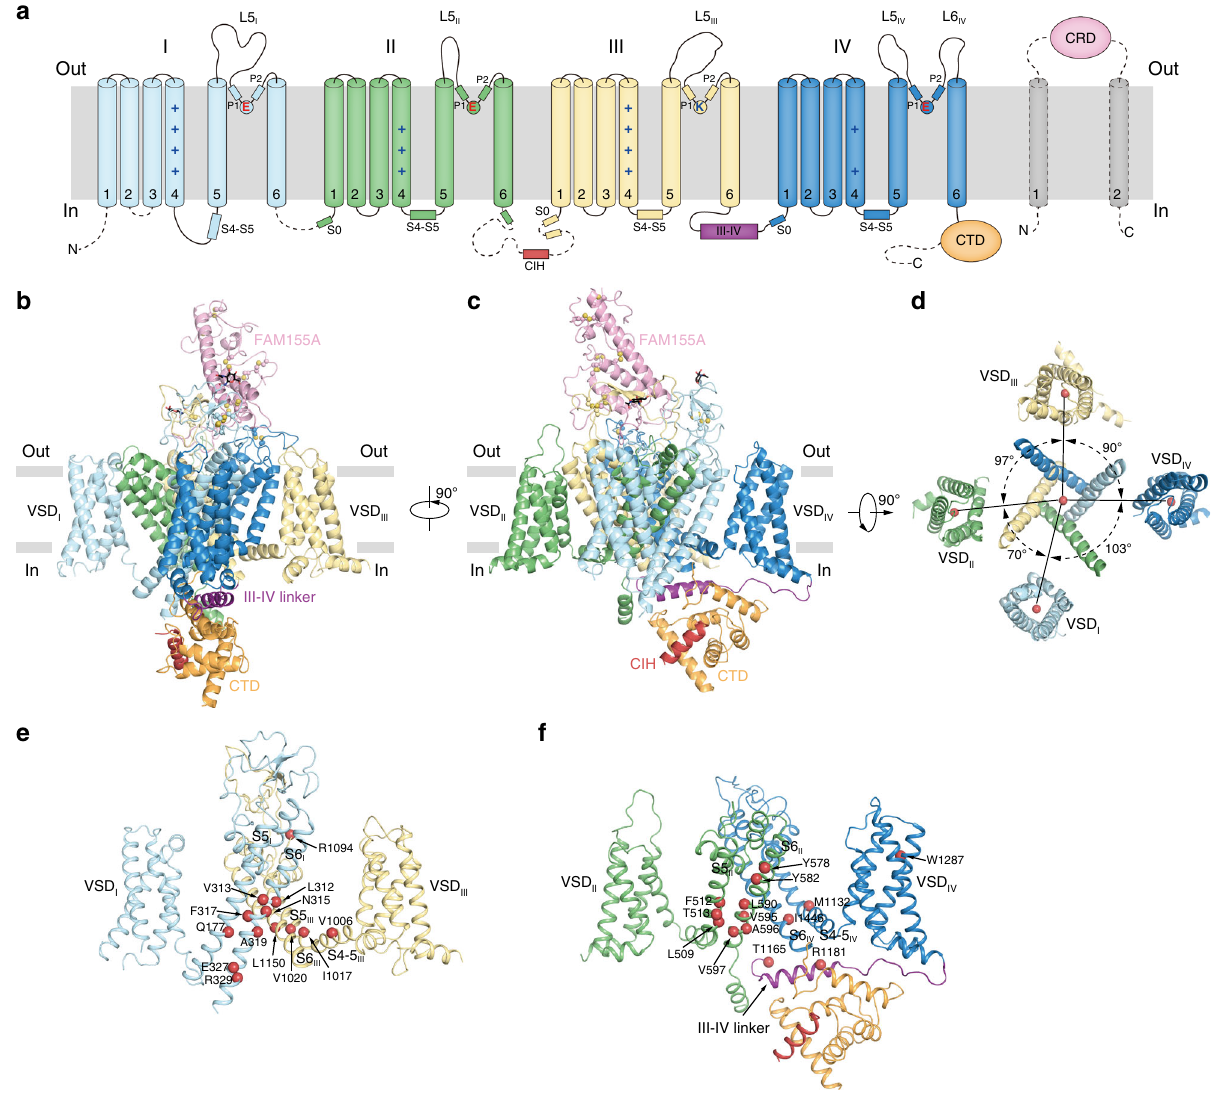
Fig. 1 Overall structure of NALCN and FAM155A complex. a Topology of NALCN and FAM155A subunits. Helices are shown as cylinders, unmodeled disordered regions are shown as dashed lines. The phospholipid bilayer is shown as gray layers. CTD C-terminal intracellular domain of NALCN. CIH CTD interacting helix of NALCN. CRD cysteine-rich domain of FAM155A. Plus signs represent positively charged residues on S4 segments. Key residues on the predicted selectivity fi lter are indicated. b Side view of NALCN and FAM155A complex. Sugar moieties are shown as black sticks, side chains of cysteine residues participating in disul fi de bond formation are shown as spheres. Sulfur atoms of disul fi de bonds were colored in gold and C α and C β atoms were colored the same as each domain. The approximate boundaries of phospholipid bilayer are indicated as gray thick lines. c A 90° rotated view compared to b . d The arrangement of the NALCN transmembrane domain illustrated in the top view. For clarity, only voltage sensors and S6 segments are shown. The angles between adjacent voltage sensors are labeled. Angular measurements were based on the center of mass positions (red spheres) of each domain. e , f Structural mapping of disease-related mutations in NALCN. For clarity, only two nonadjacent domains are shown in each panel. The C α atoms of disease-related residues are shown as red